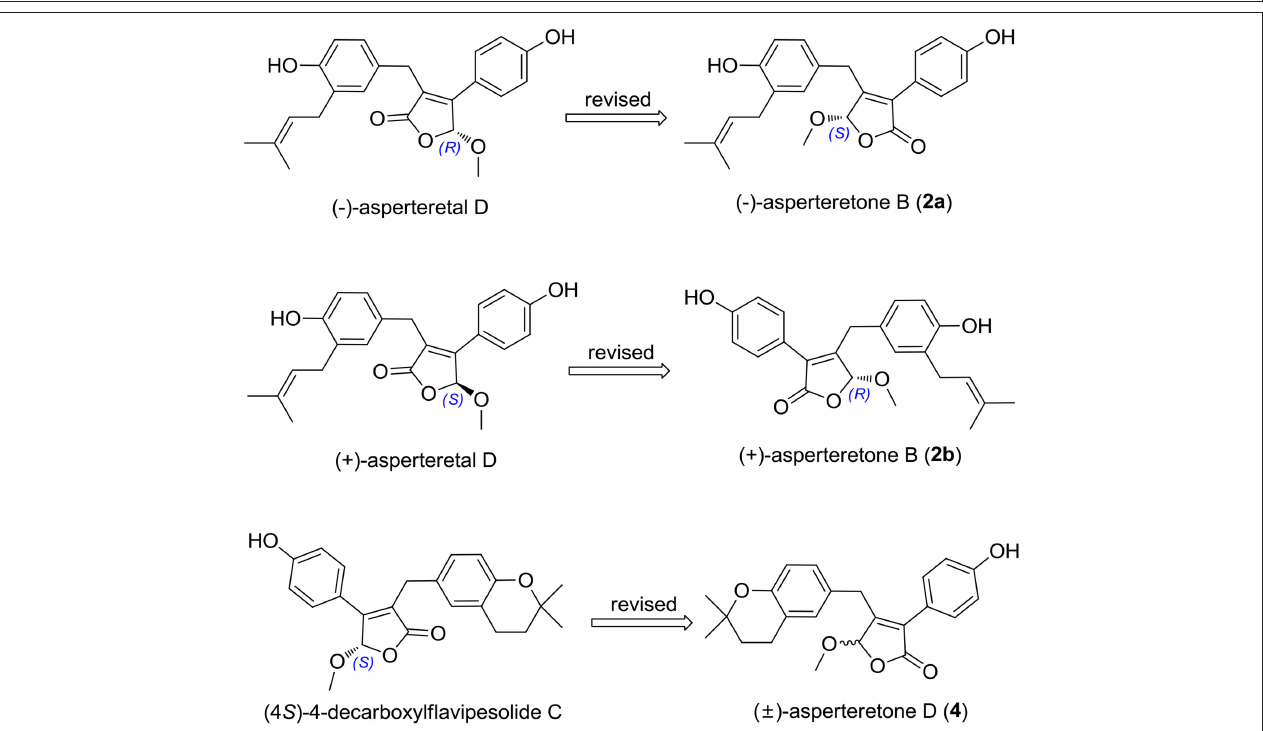
FIGURE 6 | Structure reassignments of 2-benzyl-3-phenyl-type ( B ( 2a / 2b ) and D ( 4 ), respectively.